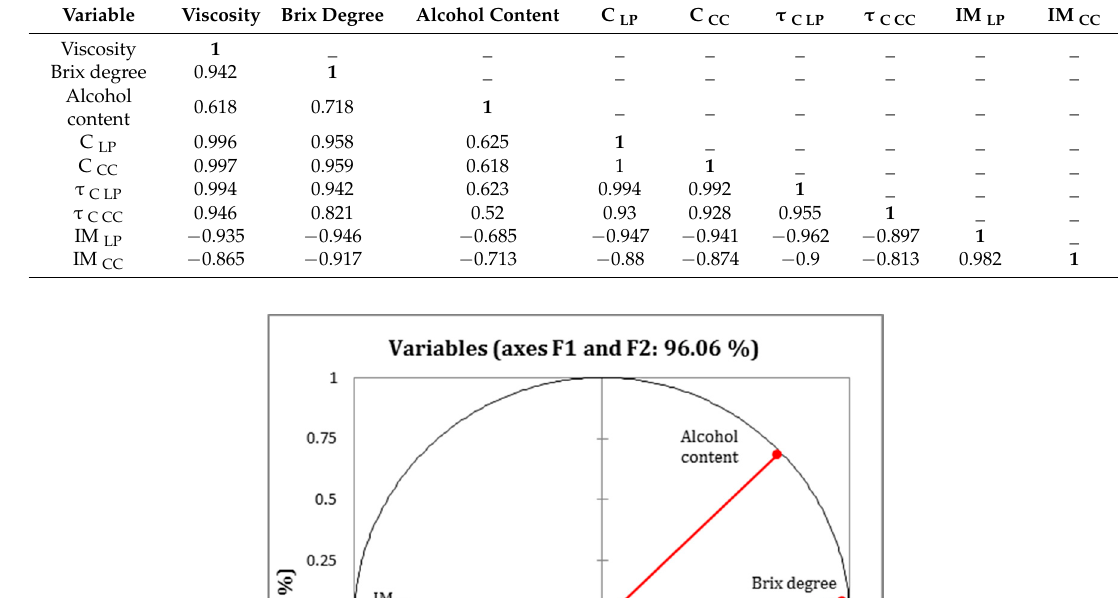
Table 2. Pearson correlation coefficient matrix between values of speckle parameters, viscosity, Brix degree, and alcohol content measurements for all wine samples.